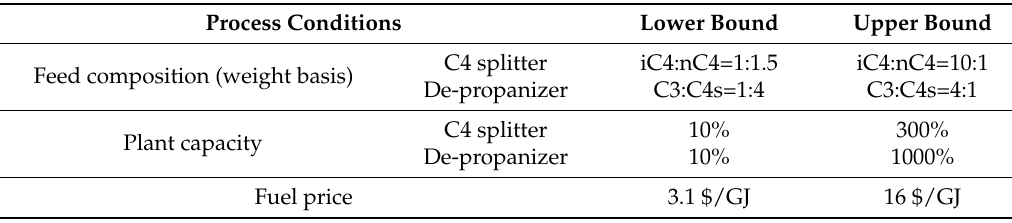
Table 2. Important process